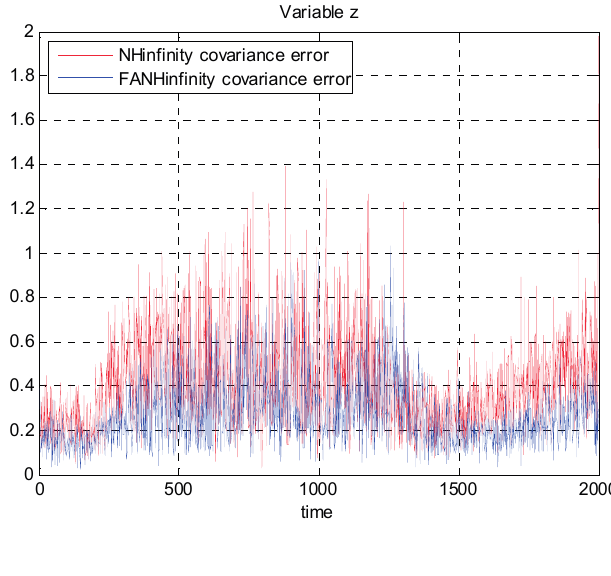
Figure 19. Error covariance in z -axes using the true